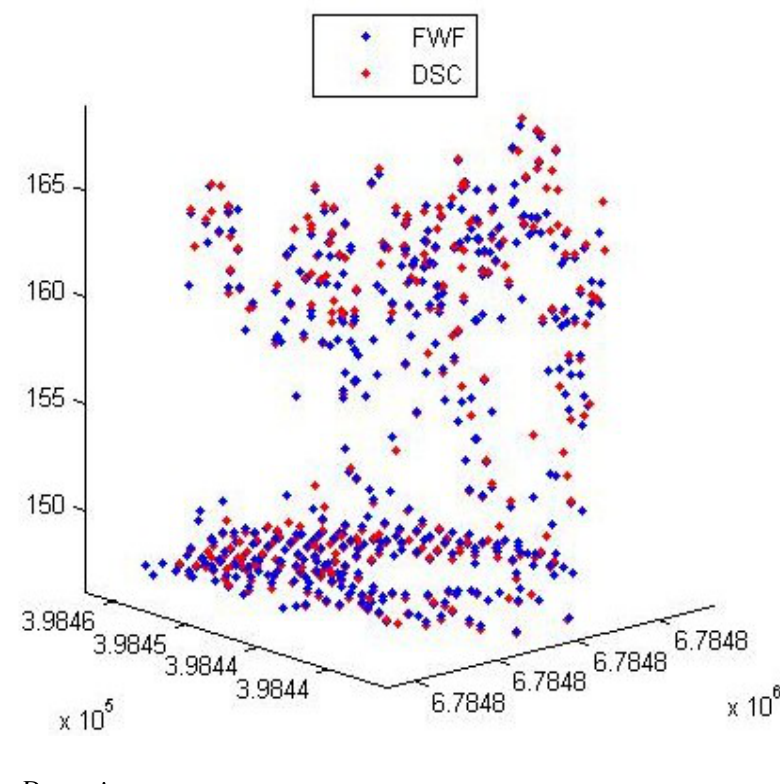
Figure 4. Point clouds produced by the system and detected from FWF in one sample plot; three hundred and ninety-one points recorded by the system and 639 points detected from